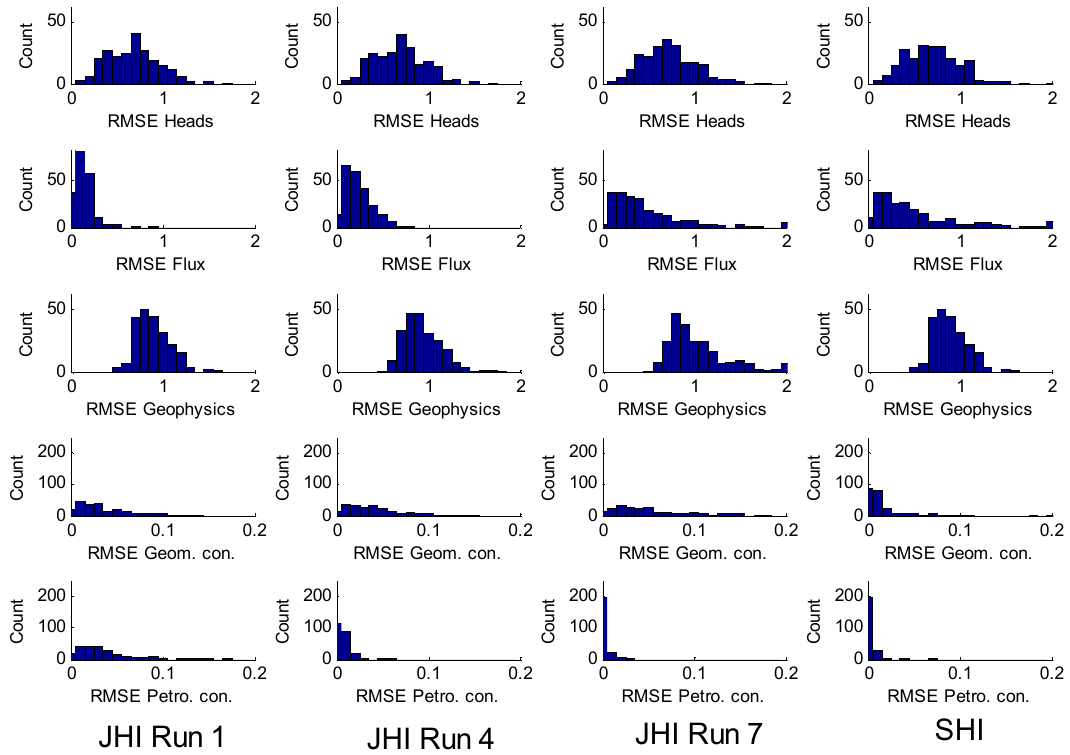
Fig. 4. Histograms of data fit for the different components of the objective function in JHI Runs 1, 4 and 7. Results are for 250 realizations. The last column shows data fit for the SHI.